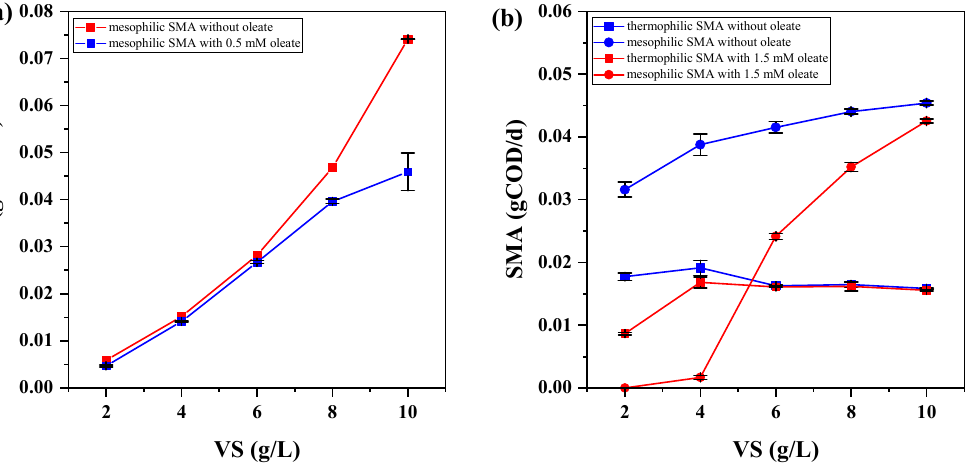
Figure 3. Effect of sludge loading rate on SMA results: ( a ) acetoclastic SMA in mesophilic sludge, ( b ) hydrogenotrophic SMA in mesophilic and thermophilic sludge.